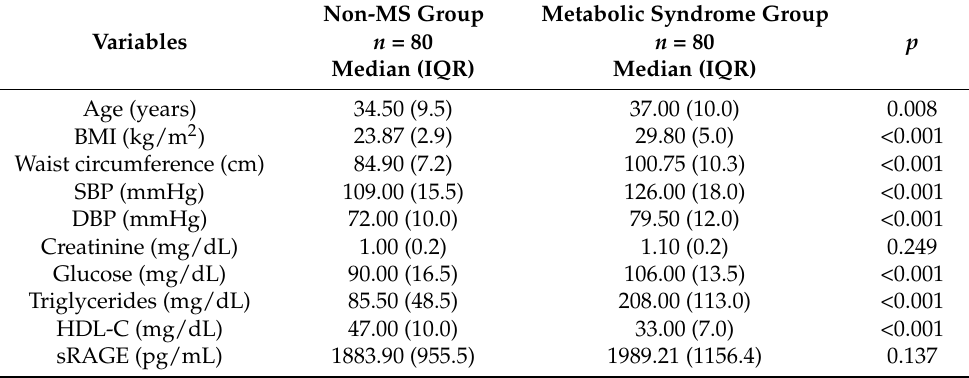
Table 1. Clinical and metabolic characteristics of the study groups.